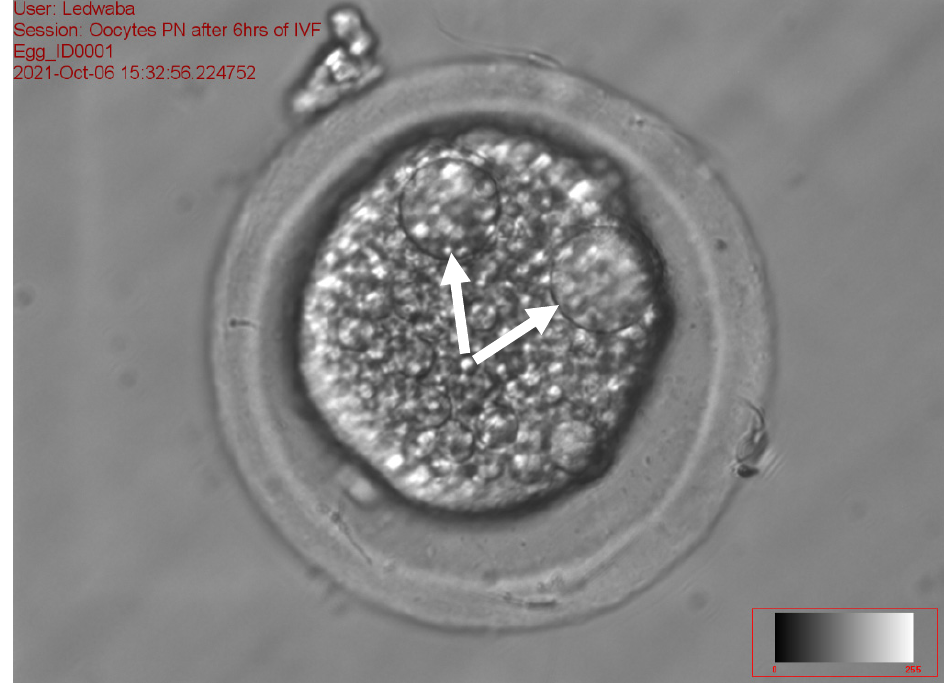
Figure 4. Zygote with the arrows showing 2 PN following in vitro fertilization at 40× magnifica- tion.